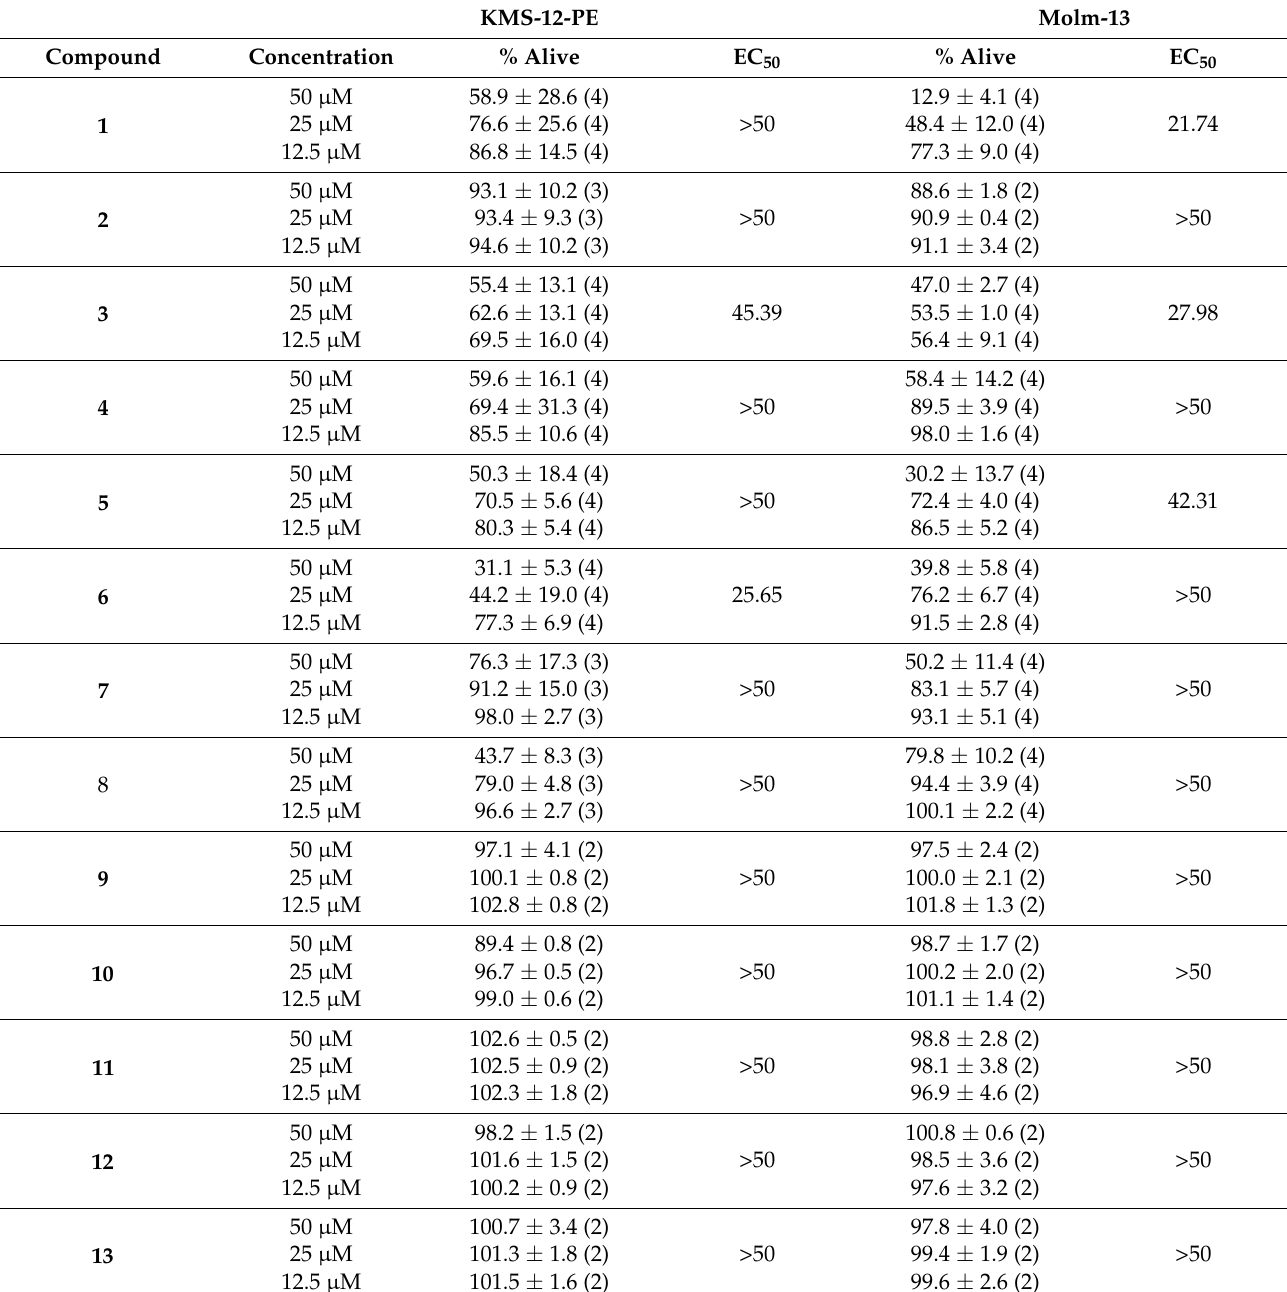
Table 1. Results of apoptosis measurements on KMS-12-PE and Molm-13 cells after treatment with different compounds and concentrations for 48 h. Results are given in percentage of cells alive of control. Number of independent experiments is given in parentheses. EC 50 values were calculated using the “best-fit” model and are given in µ